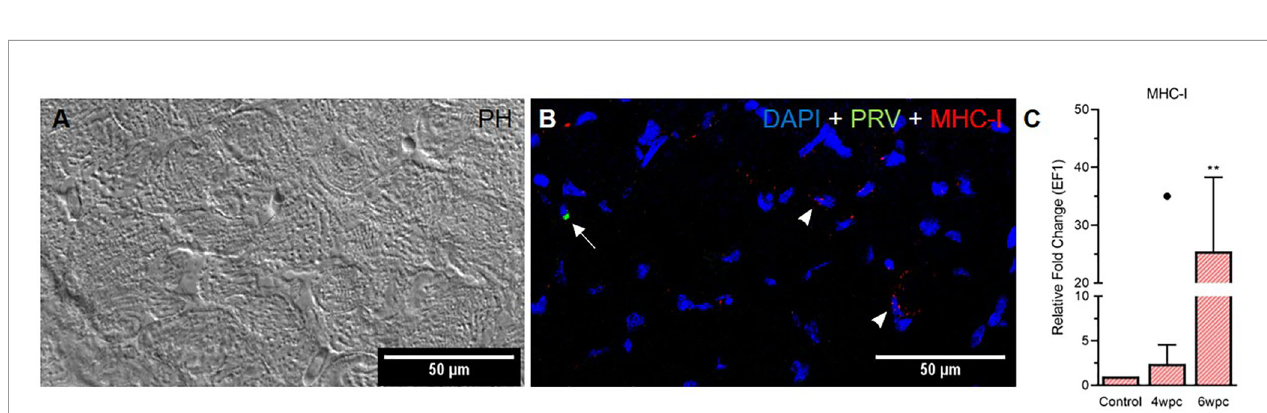
FIGURE 6 | Fluorescent in situ hybridization (FISH) of PRV-1 and MHC-I in skeletal muscle at peak of HSMI associated histopathological changes (6 wpc). (A) Phase contrast image showing myocyte structure (B) Merged image showing MHC-I (red) positive cells (arrowheads) and PRV-1 (green) infected cells (arrow). Nuclei stained with DAPI (Blue) (Scale Bar = 50 µm). (C) Relative fold change expression (medians) of MHC-I at 4 wpc and 6 wpc normalized against EF1 a . Dot sign shows outlier value from the respective fi sh group. (*) shows signi fi cantly difference from the control (**p <